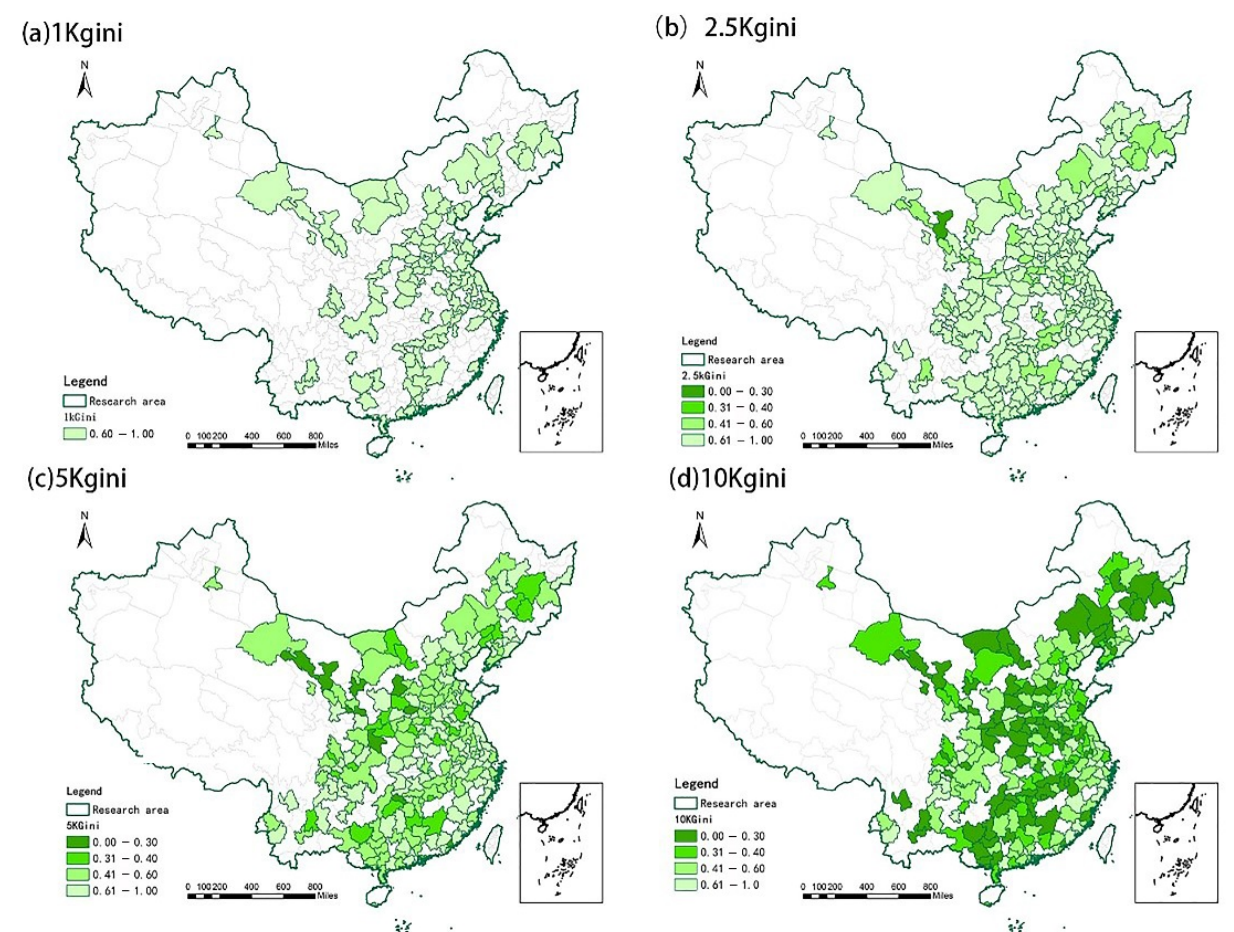
Figure 4. The Gini coefficient of spatial accessibility of the study area when ( a ) d 0 = 1 km; ( b ) d 0 = 2.5 km; ( c ) d 0 = 5 km; and ( d ) d 0 = 10 km.